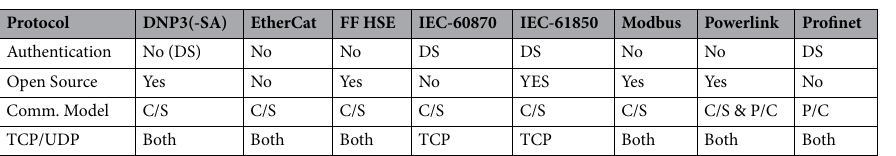
Table 1. SCADA communications protocols and their characteristics. C/S: Client/Server communications model. DS: Digital Signature. DNP3: Distributed Network Protocol 3. DNP3-SA: Distributed Network Protocol 3 Secure Authentication. FF HSE: Foundation Fieldbus High Speed Ethernet. IEC: International Electrotechnical Commission. P/C: Producer/Consumer communication model. SA: Secure